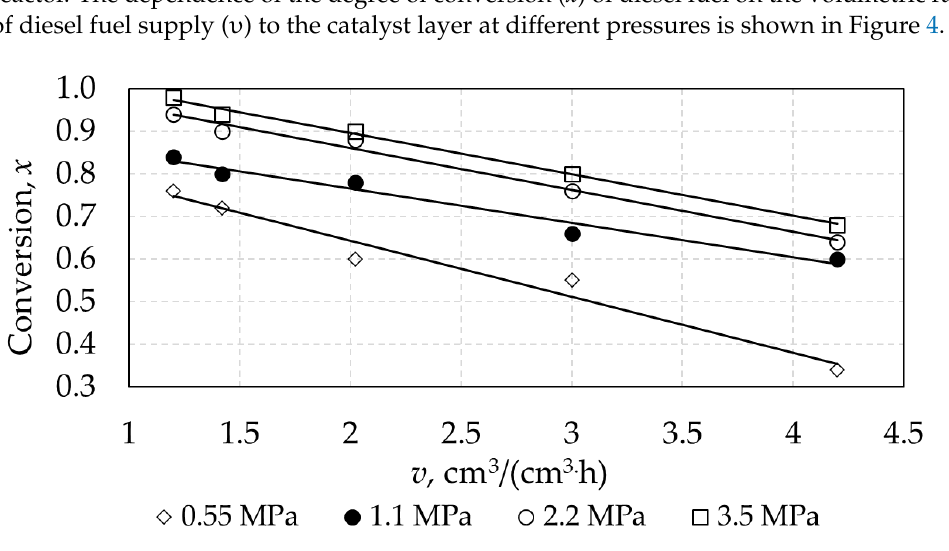
Figure 3. Correlation between − ln(1 − х ) and Р/( 1 + Р ) over different volumetric flow rate (  ) of the diesel fraction.